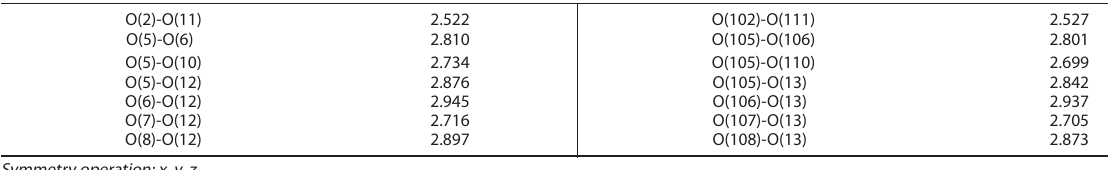
Table 3. Intramolecular H-bonds (Å) observed in the structure of complex 1 .